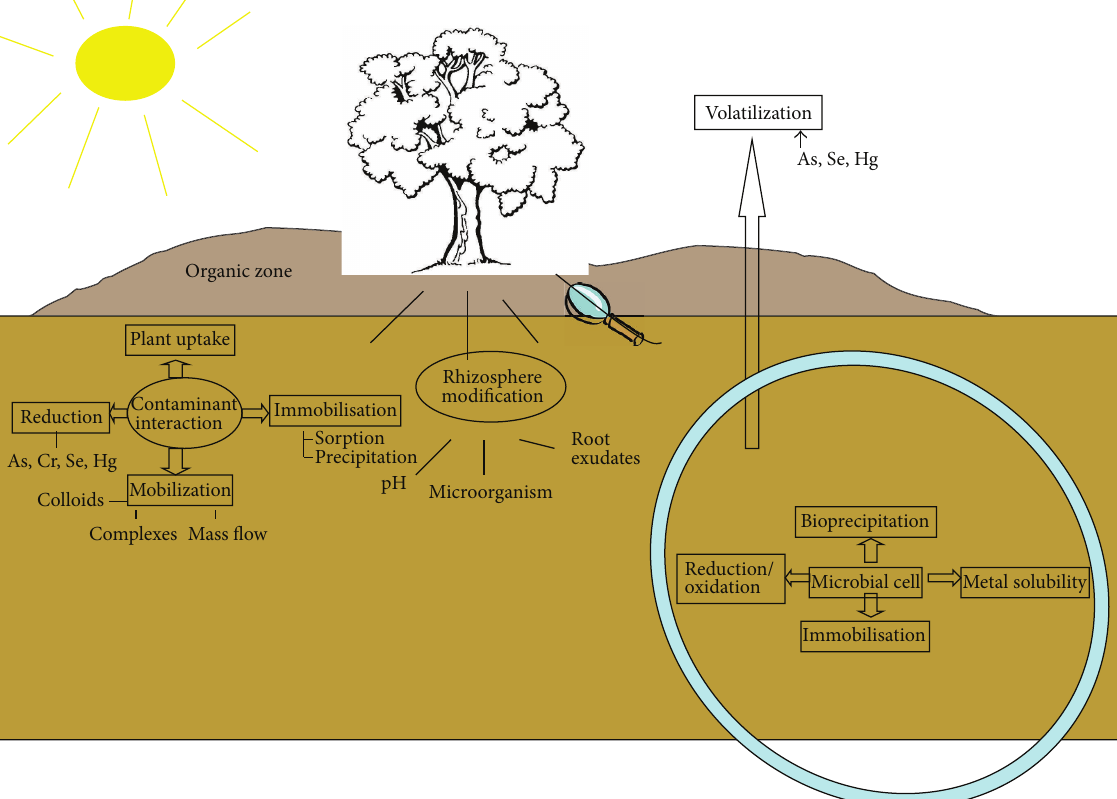
Figure 4: The role of organic amendments in regulating various bioremediation processes (extracted from [57]).